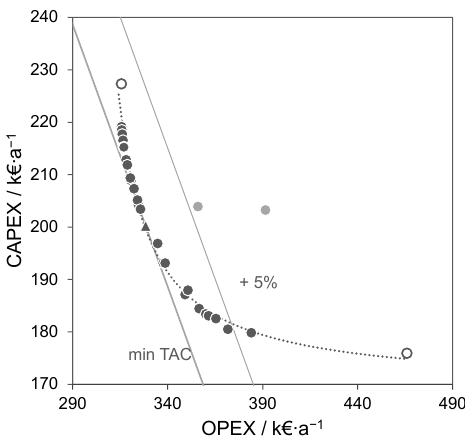
Figure 9. Set of Pareto-optimal solutions for the heteroazeotropic distillation of ethyl acetate and isooctane using acetonitrile as solvent. The white circles indicate the individual optimization of the OPEX and CAPEX, respectively, and the thick and thin lines are lines of constant TAC for the lowest costs and an additional 5%. The light-gray circles denote locally optimized but finally sub-optimal solutions, which are not in close vicinity to the approximated Pareto front and omitted for the fit of Equation (2) shown as a dotted line.